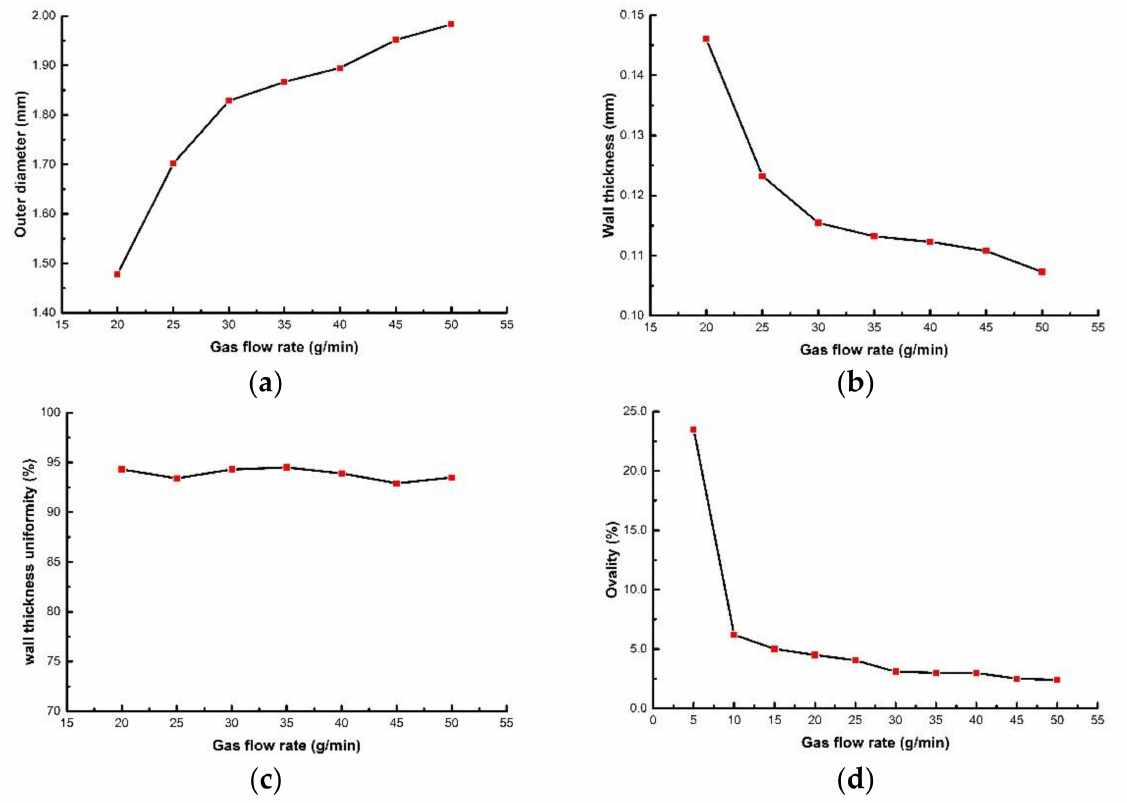
Figure 14. The relationships between evaluation index with gas flow rate: ( a ) The relationship between outer diameter with gas flow rate; ( b ) The relationship between wall thickness with gas flow rate; ( c ) The relationship wall thickness uniformity with gas flow rate; ( d ) The relationship between ovality with gas flow rate.